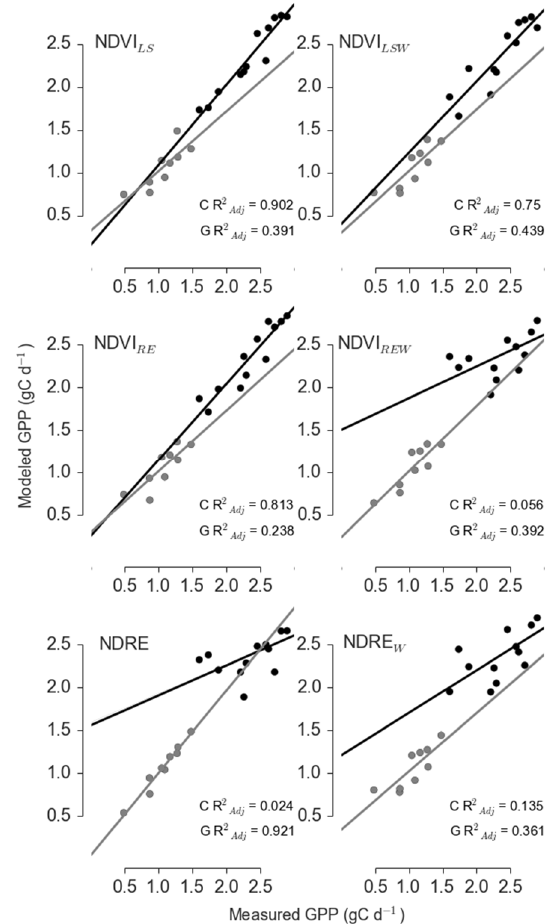
Figure 3. One to one plots of tower derived (measured) and predicted (modeled) gross primary